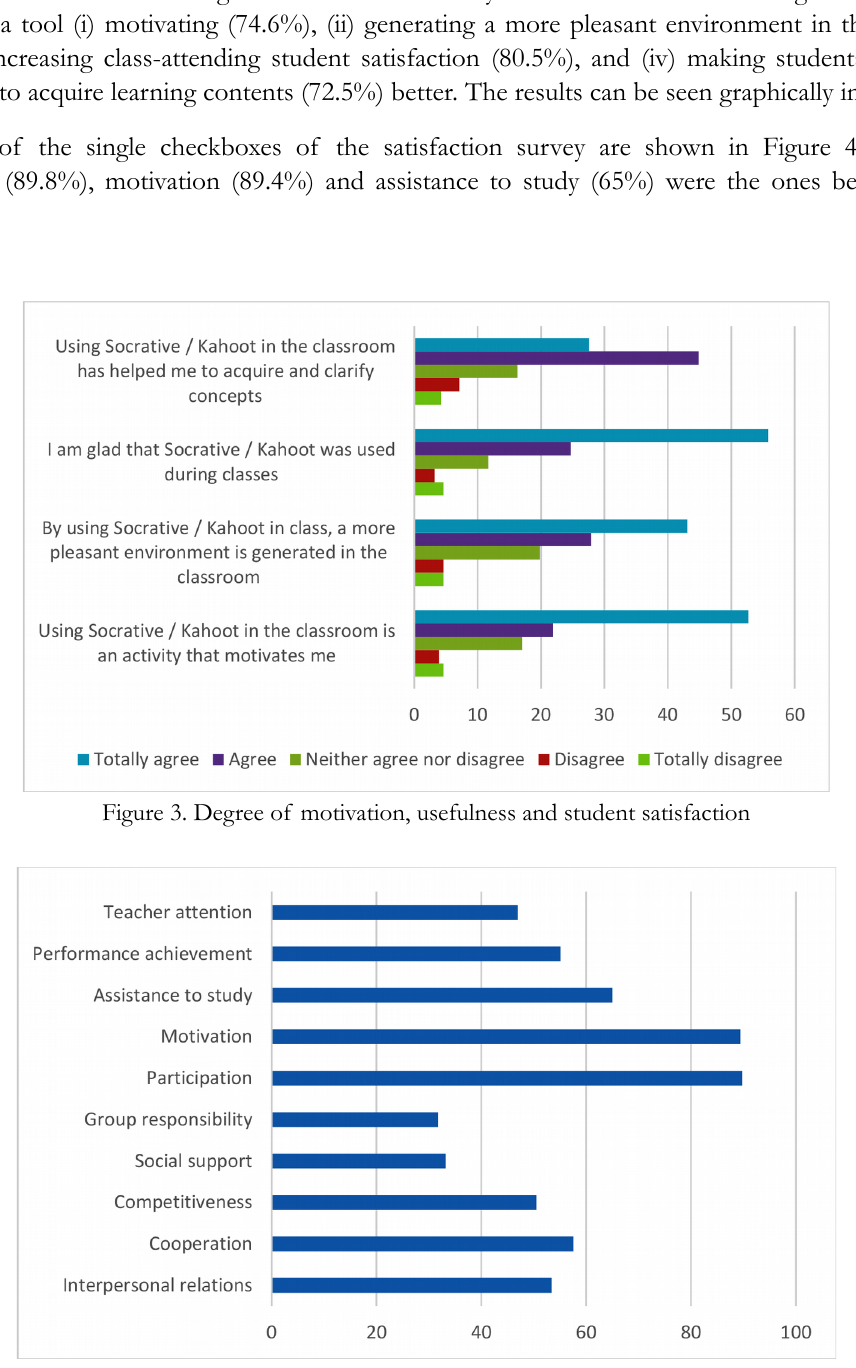
Figure 4. Assessment of students in the single checkboxes of the satisfaction